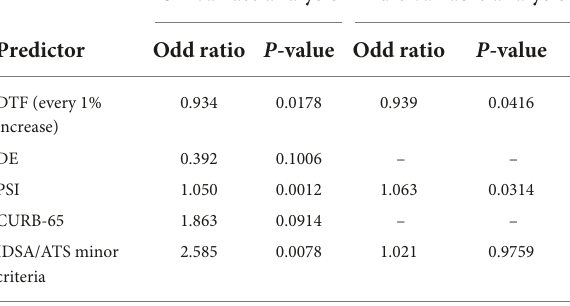
TABLE 2 Logistic regression of risk stratification tools for predicting respiratory failure in patients with community-acquired pneumonia. Univariate analysis Multivariable analysis